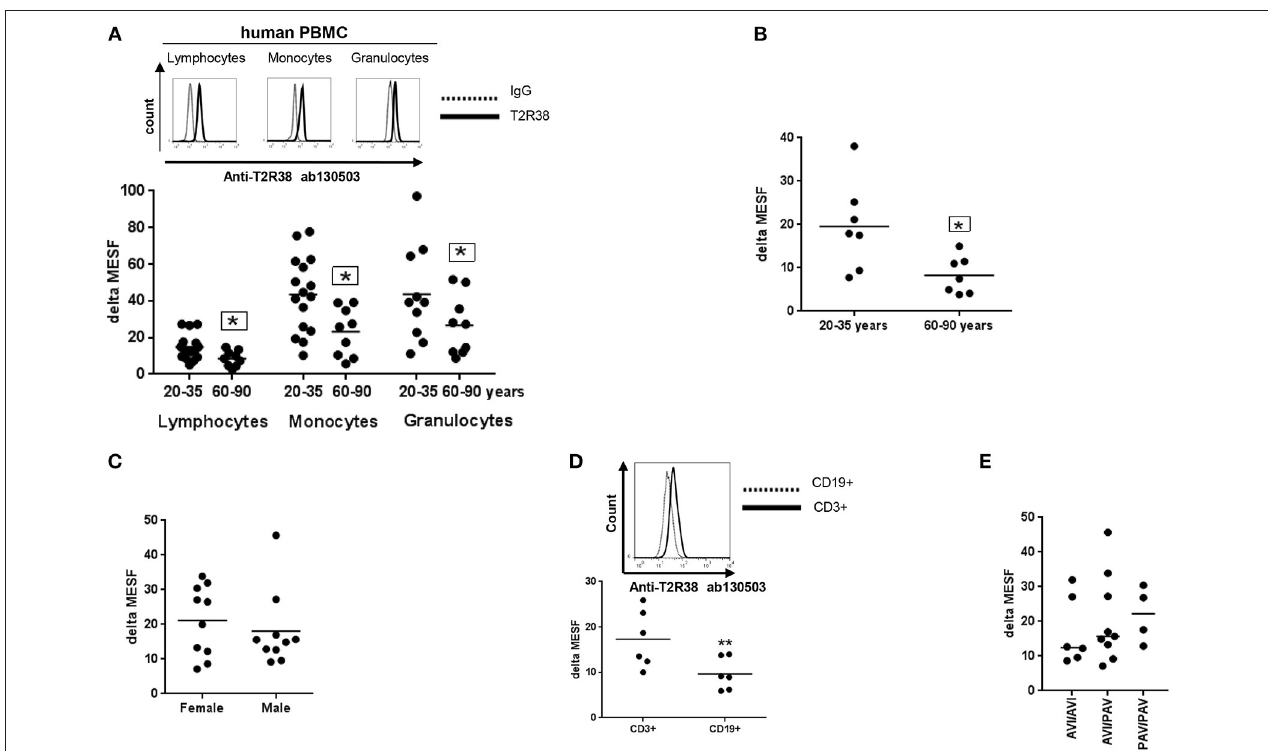
FIGURE 1 | Expression of T2R38 receptor in human PBMC. (A) Age-related T2R38 expression in PBMC from young (20–35 years, n ≥ 10) and elderly (60–90 years, n = 9) subjects. A representative staining from one person is shown for each cell type; T2R38 (continuous line) and rabbit IgG (dotted line). (B) T2R38 expression in CD3 + T cells from young ( n = 7) and elderly ( n = 7) donors (C) Sex difference of T2R38 expression in lymphocytes from male and female donors ( n = 10). (D) T2R38 expression in CD3-PE stained T cells and CD19-APC stained B cells from human volunteers, ( n = 6). A representative staining from one person is shown; CD3 + (continuous line) and CD19 + (dotted line). (E) Haplotype analysis was done using amplification of a TAS2R38 864bp fragment followed by sequencing. PAV: p roline, a lanine and v aline; AVI: a lanine, v aline and i soleucine ( n = 19). T2R38 expression (delta MESF) was quantified by Quantum Alexa Fluor 488 MESF